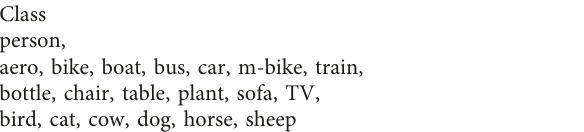
Table 1: Classes of Pascal VOC datasets. Class